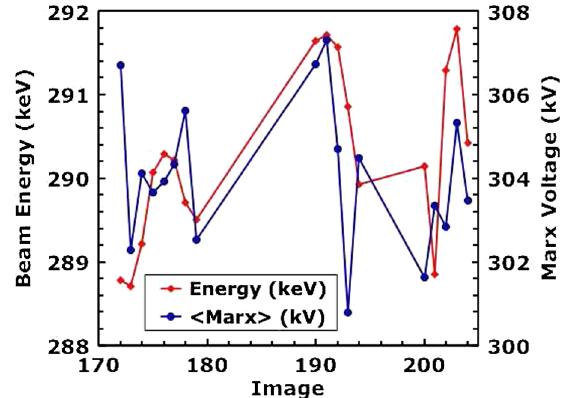
FIG. 9. Correlation of the average Marx voltage (blue for 1 : 25 < Time ð (cid:1) s Þ < 1 : 75 ) with individual measurements of the energy profile (red) made with the CCD camera (note scale